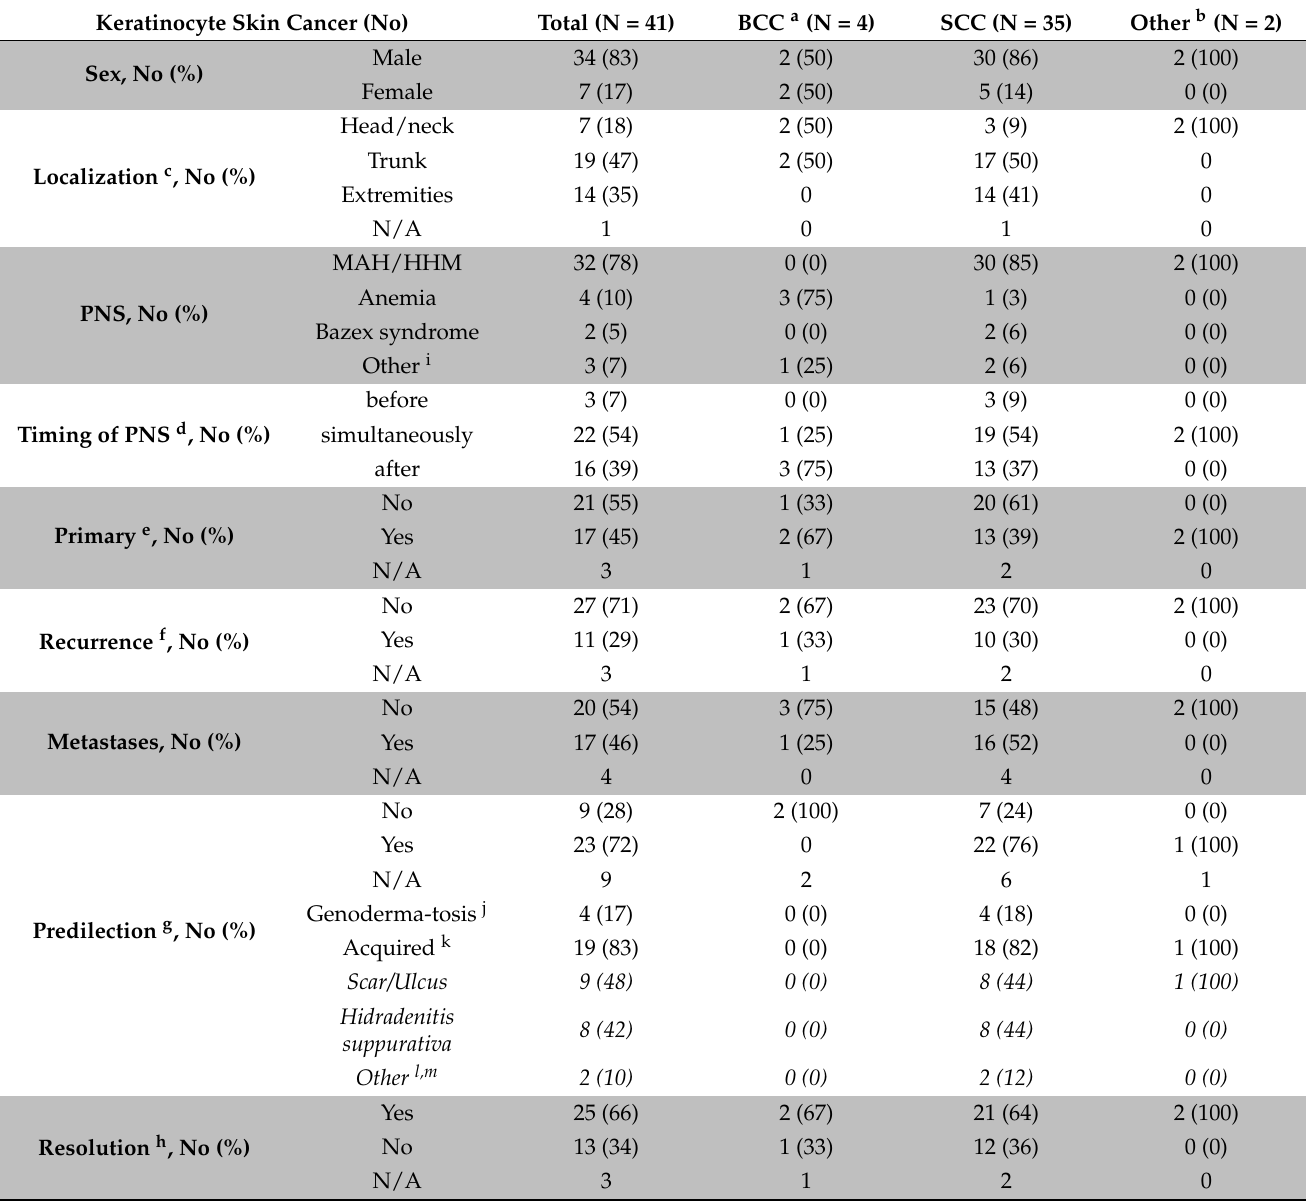
Table 2. Paraneoplastic syndromes in patients with keratinocyte skin cancer. Compilation of the clinical features of all cases and separately for the different skin cancer types. No (%): Number of cases and % of corresponding cases with available